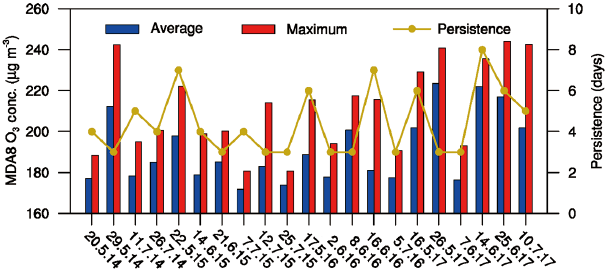
Figure 3. Mean (blue bars) and maximum (red bars) MDA8 O 3 concentrations (µgm − 3 ) averaged over North China for each of the 21 OPEs that occurred during the months of May to July of 2014– 2017. The dotted yellow line indicates the persistence (days) of each